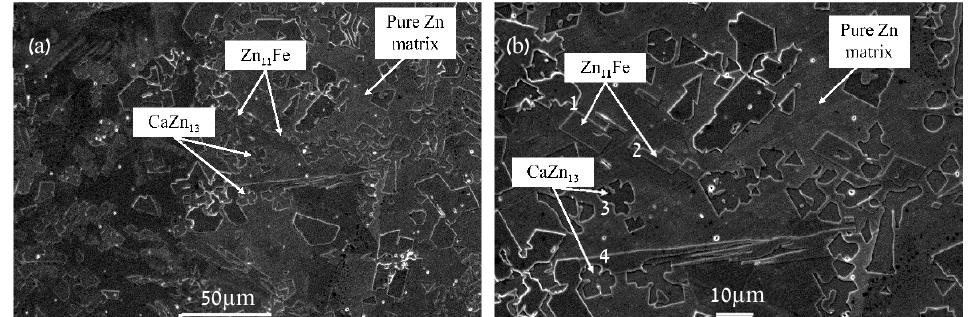
Figure 2. Typical microstructure of biodegradable Zn-2%Fe-0.6%Ca alloy obtained by SEM in two different magnifications ( a ) X500, ( b ) X1000. Table 1. EDS results summary.